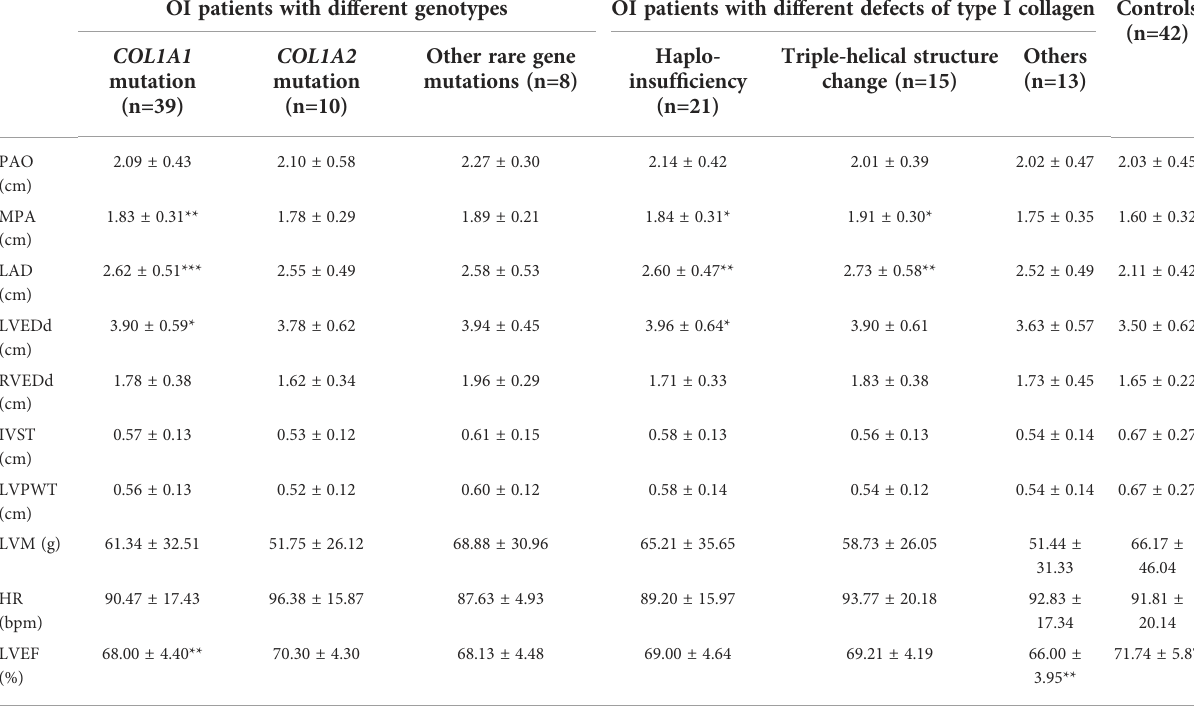
TABLE 4 Echocardiographic parameters in OI patients with different genotypes and defects of type I collagen compared with controls. OI patients with different genotypes OI patients with different defects of type I collagen Controls